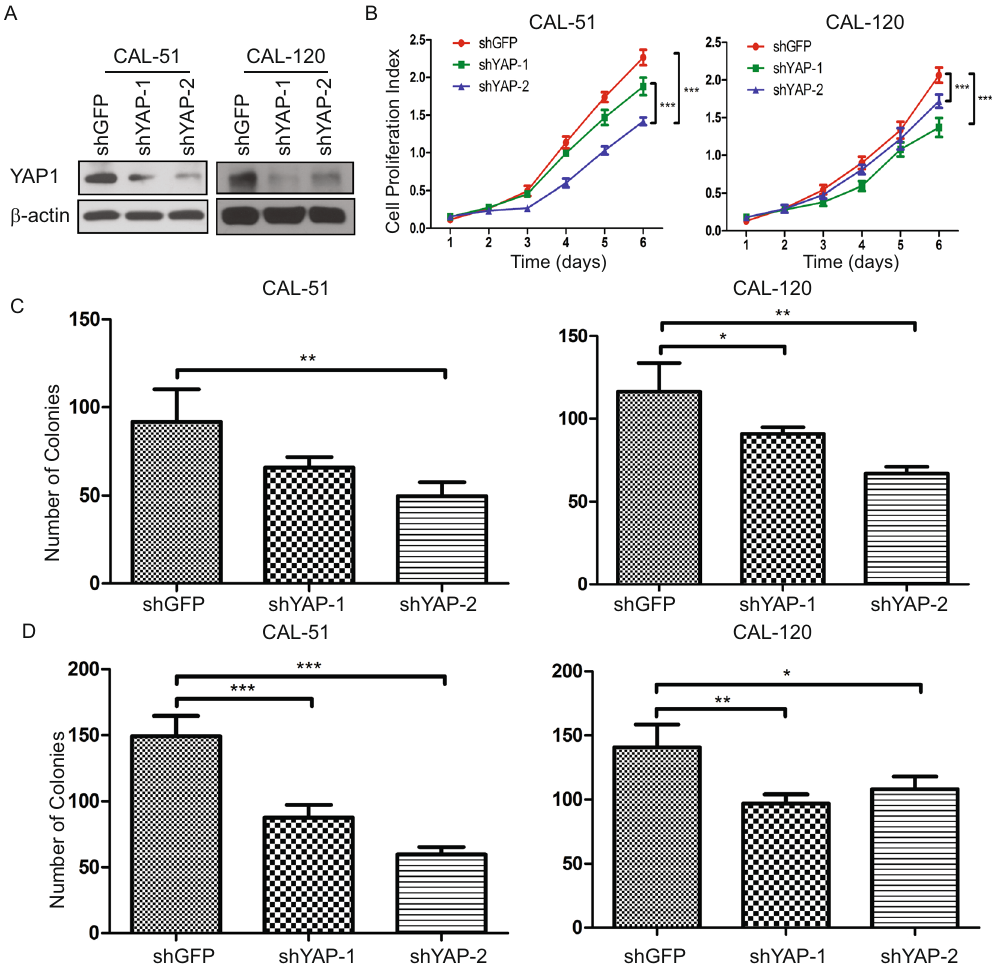
Figure 5. Knockdown of YAP inhibits breast cancer cell proliferation. ( A ) YAP knockdown efficiency in CAL- 51 and CAL-120 cells by immunoblot. ( B ) Cell proliferation by the MTT assay for shGFP- or shYAP-transduced CAL-51 and CAL-120 cells. Quantification of colony-formation ( C ) and anchorage-independent growth in soft agar ( D ) for shGFP- or shYAP-transduced CAL-51 and CAL-120 cells. ( * P < 0.05, ** P < 0.01, *** P <